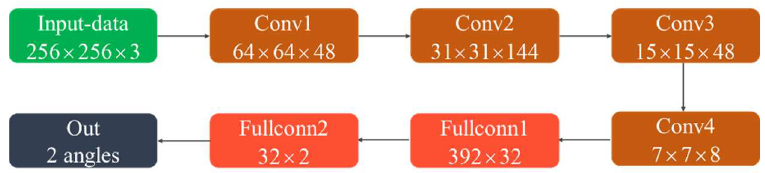
Figure 7. CNN structure used in the elevation angle calculation.